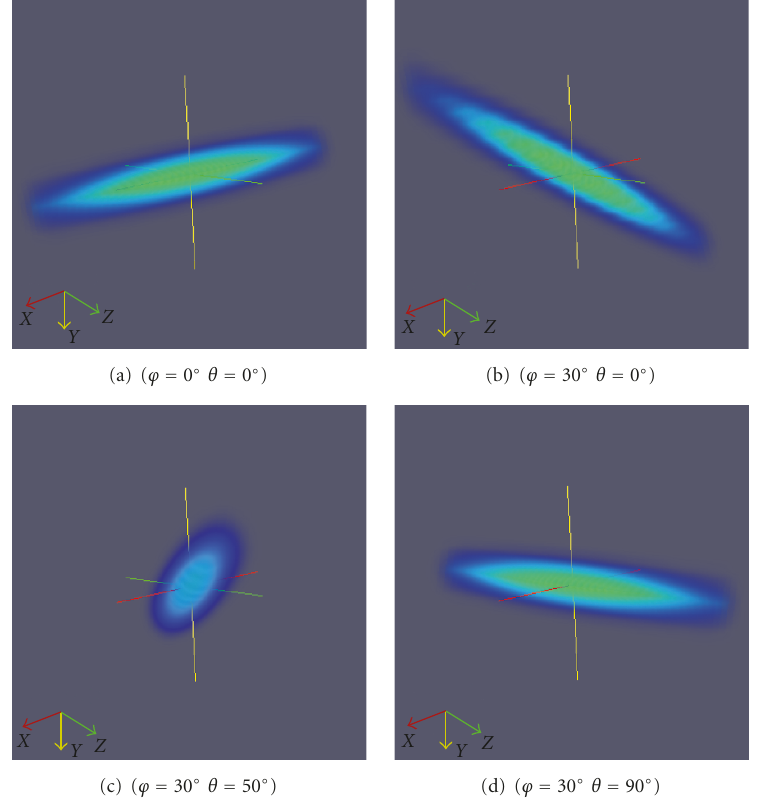
Figure 5: Representation of 3D filters for di ff erent pairs ( ϕ , θ